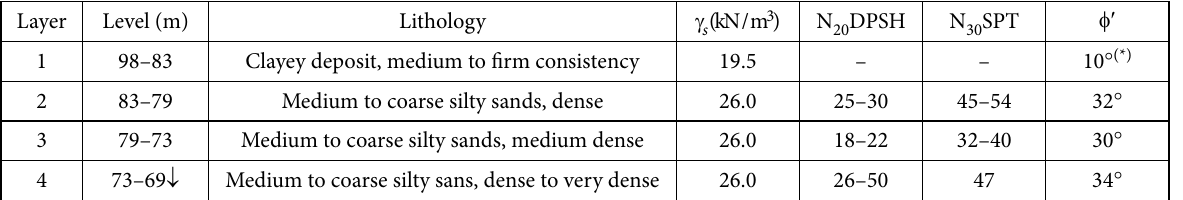
Table 1. Simplified subsoil structure